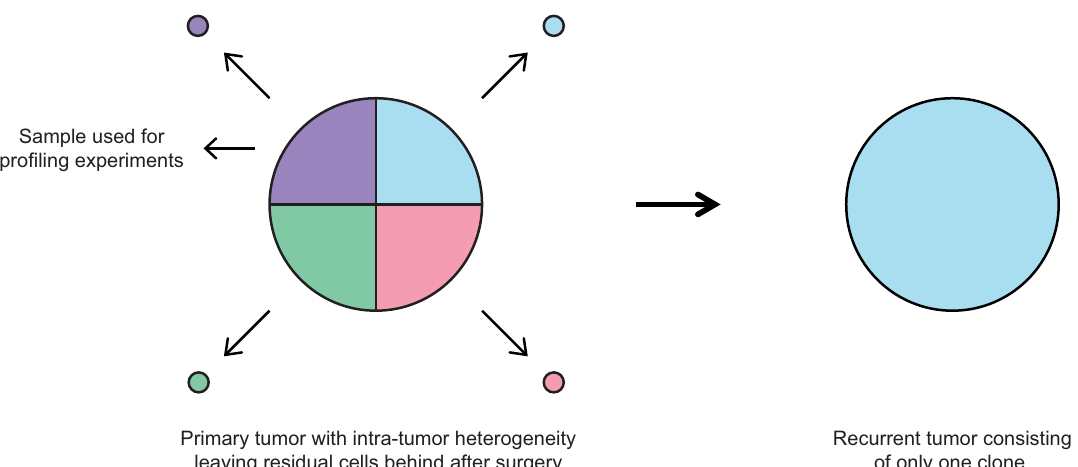
Fig 5. Schematic overview of the concept of intra-tumor heterogeneity in the context of the current study. If the primary tumor sample that was used for the experiments mainly consists of one specific cancer cell subtype, but the recurrent tumor is a recurrence of mainly other cancer cell subtypes, this might explain the large variability in DNA methylation and microRNA expression, even in case of short time to recurrence.